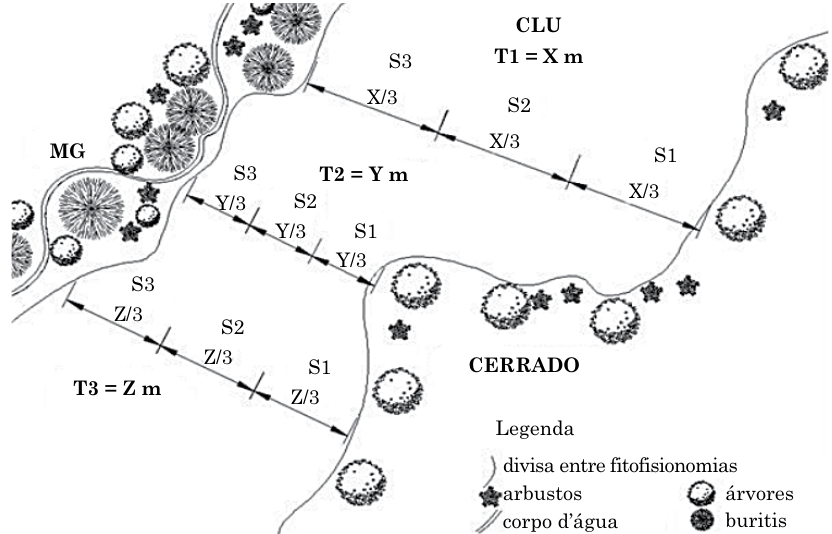
Figura 1. esquema amostral de solos, capim dourado e de medições de declividade do terreno nas veredas selecionadas para o estudo. t: transeções; s: segmentos; mg: mata de galeria; e clu: campo limpo